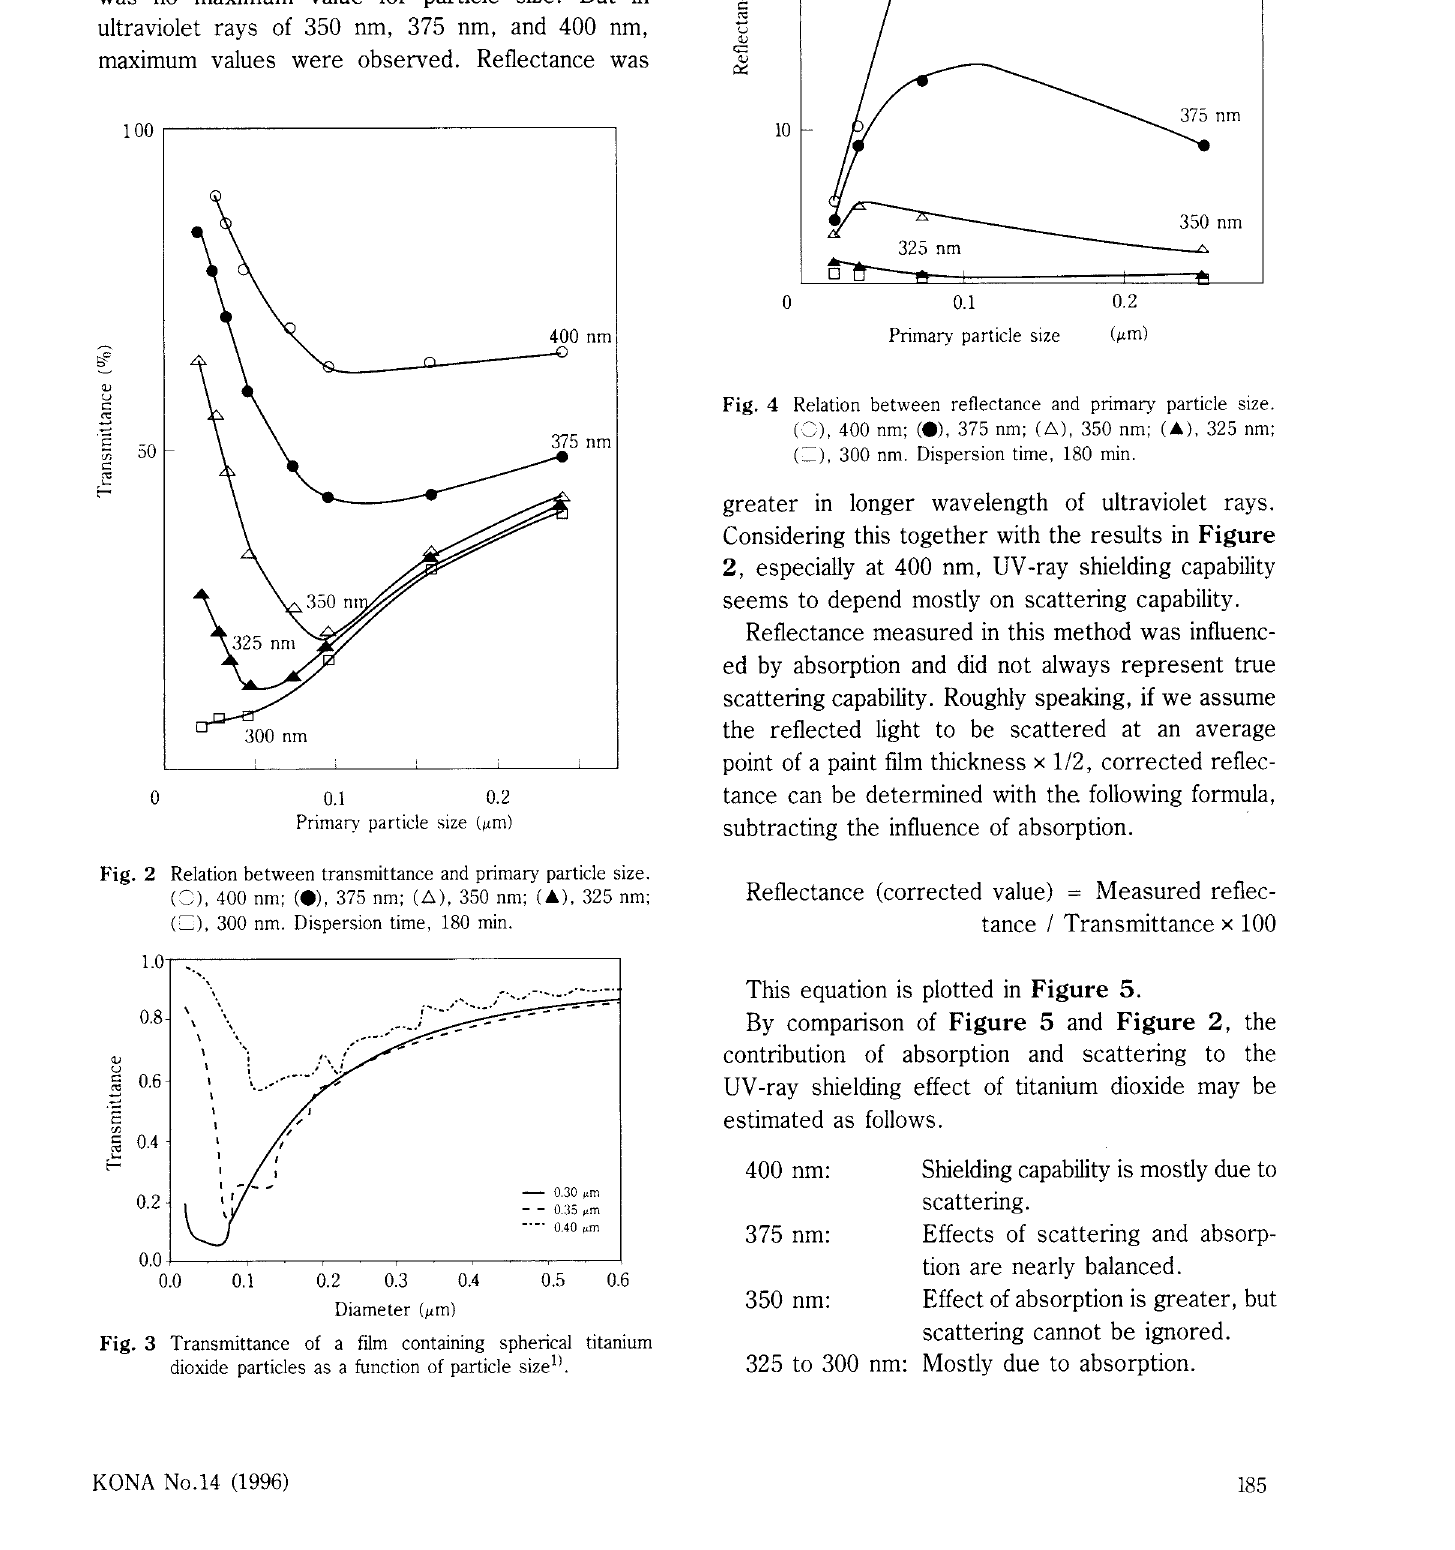
Fig. 3 Transmittance of a film containing spherical titanium dioxide particles as a function of particle size!).